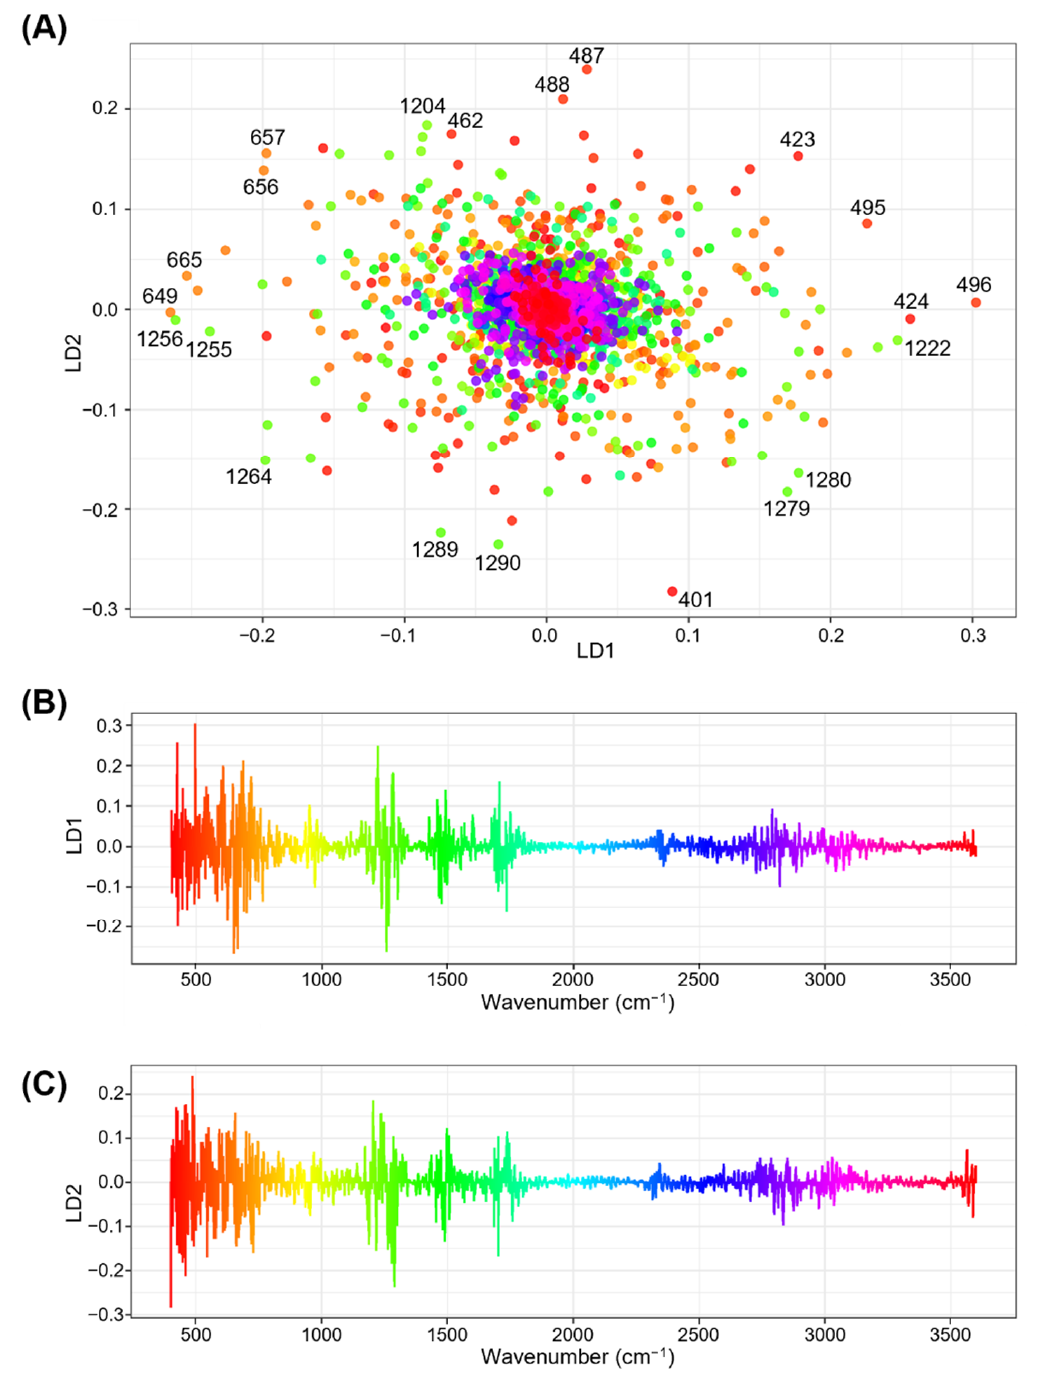
Figure 6. Relationships between the coefficients of the first two linear discriminants (LD1 and LD2) and wavenumbers in linear discriminant analysis (LDA). ( A ) Two-dimensional scatter plot for the coefficients of linear discriminant LD1 and LD2. Respective points represent the wavenumbers from 400 to 4000 cm − 1 . Assignment of color gradients to respective wavenumbers are the same as those presented in ( B , C ). Numbers in black font at respective color points designate wavenumbers for characteristic data points with higher absolute coefficient values ( B , C ). One-dimensional column plots showing relationships between wavenumbers and coefficients of ( B ) LD1 and ( C ) LD2. The coefficient values for each wavenumber are expressed using a rainbow color gradient along their x